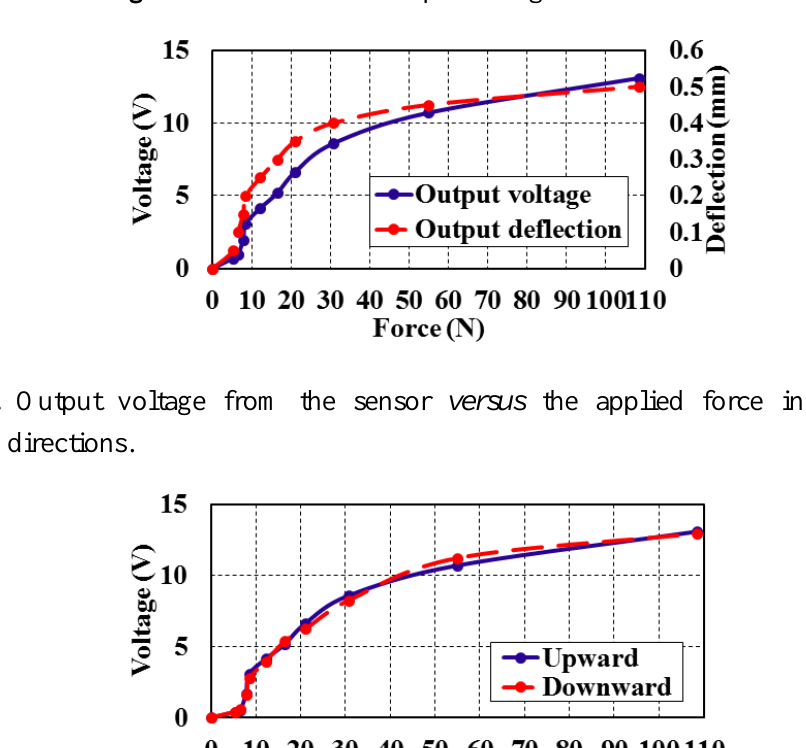
Figure 7. Force versus output voltage and deflection.